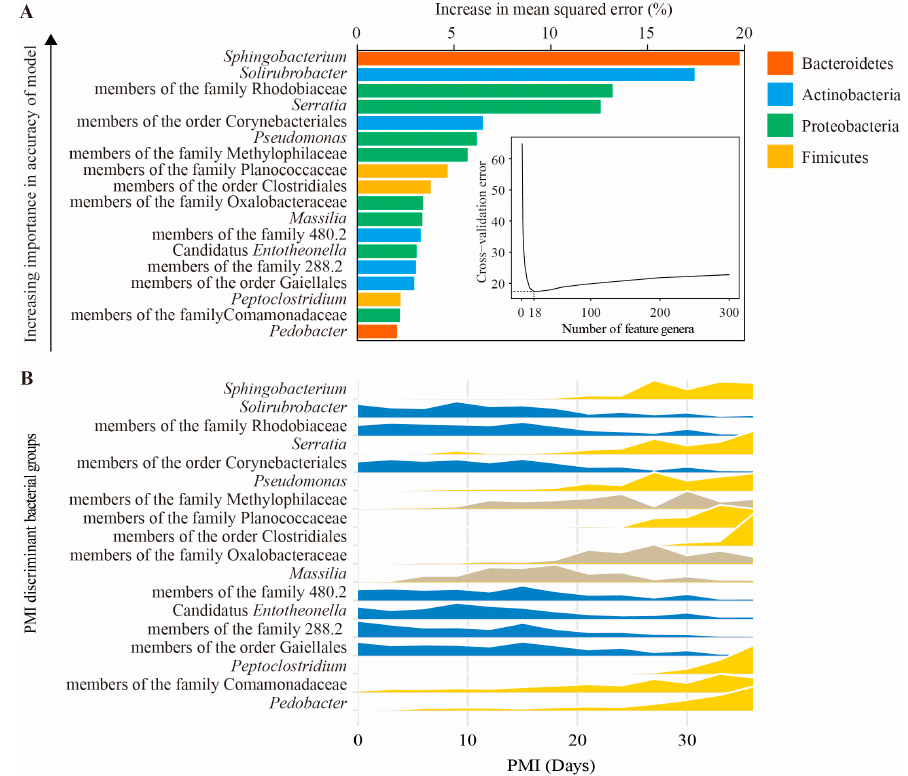
Figure 4. Bacterial taxonomic biomarkers of gravesoils during cadaver decomposition. ( A ) The top 18 biomarker bacterial genera were identified by applying a random forest model of their relative abundances in gravesoils against PMIs. Biomarker taxa are ranked in descending order of importance to the accuracy of the model. The inset represents a 10-fold cross-validation error as a function of the number of input genera used to regress against PMIs. ( B ) Abundance profiles for PMI-discriminant genera in gravesoils. Genera are colored by their classification as early, late, or complex colonizer patterns. There were 8 genera (yellow) with increasing relative abundances, 3 genera (gray) with complex patterns and 7 genera (blue) with decreasing relative abundances during cadaver decomposition.